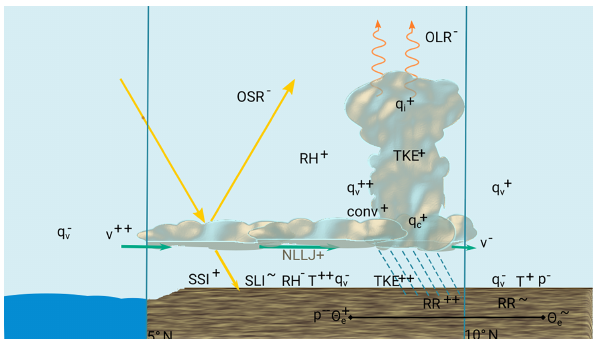
Figure 14. Conceptual sketch of the most important changes when reducing the optical thickness of low clouds based on the ICON EXPL experiments. For more details see Sect.